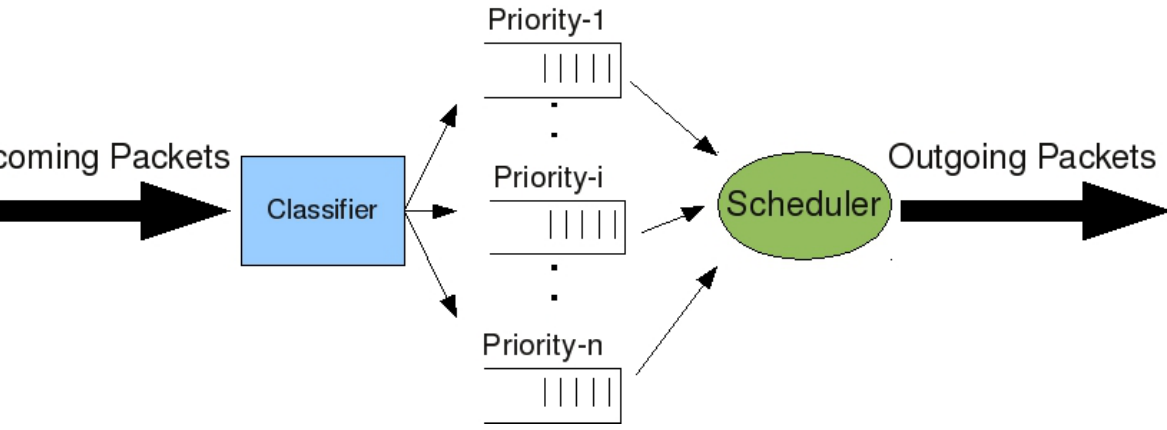
Figure 2. Traffic Differentiation and Priority Queueing in